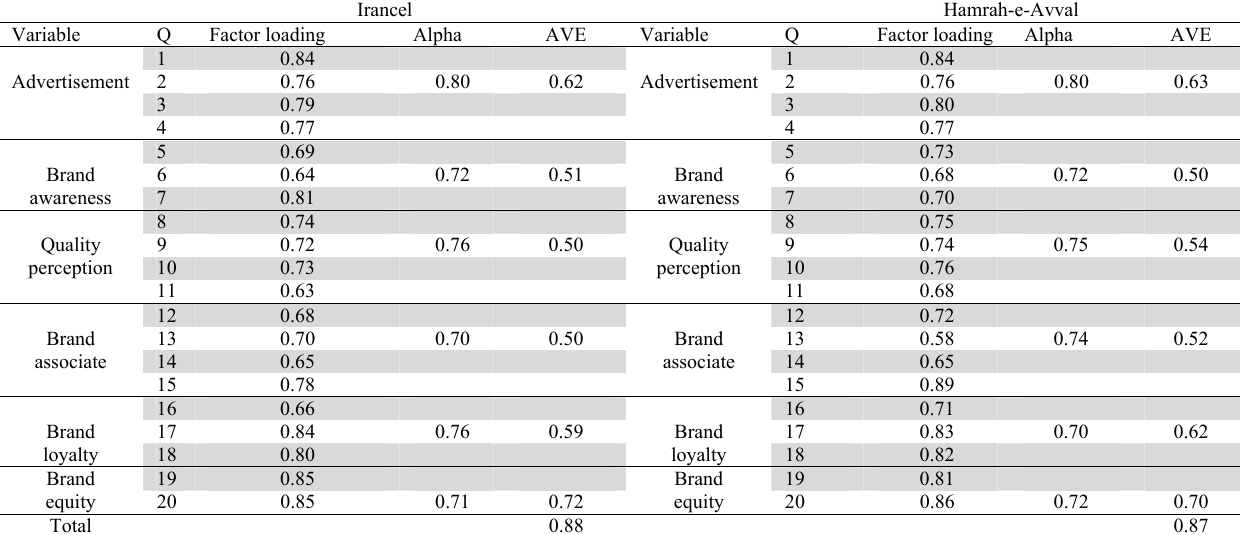
The summary of Cronbach alpha